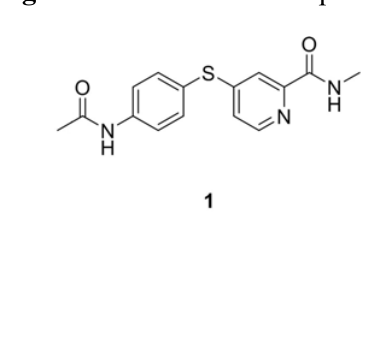
Figure 2. Structure of compound 1